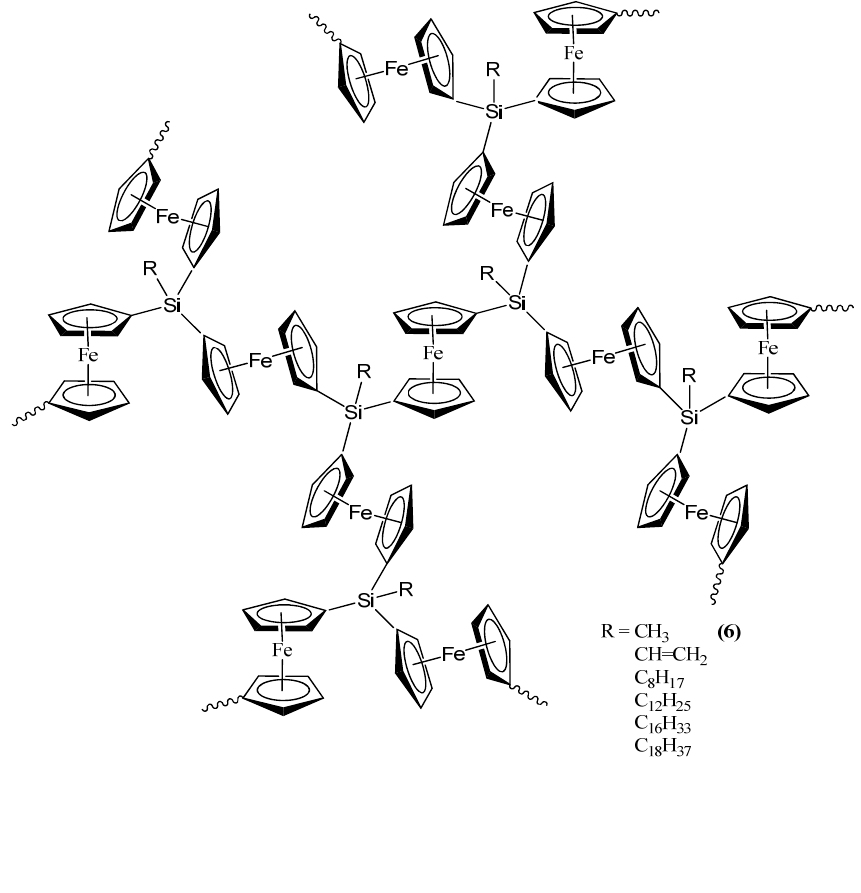
Figure 5. The methyl-containing hyperbranched poly[1,1’-ferrocenylene(methyl)silyne], 6 , used in the production of the Fe Si-containing product 7A . Shown, also, are the variants of 3 6 that were utilized in the study. Adapted from Ref. [65] with permission from American Chemical